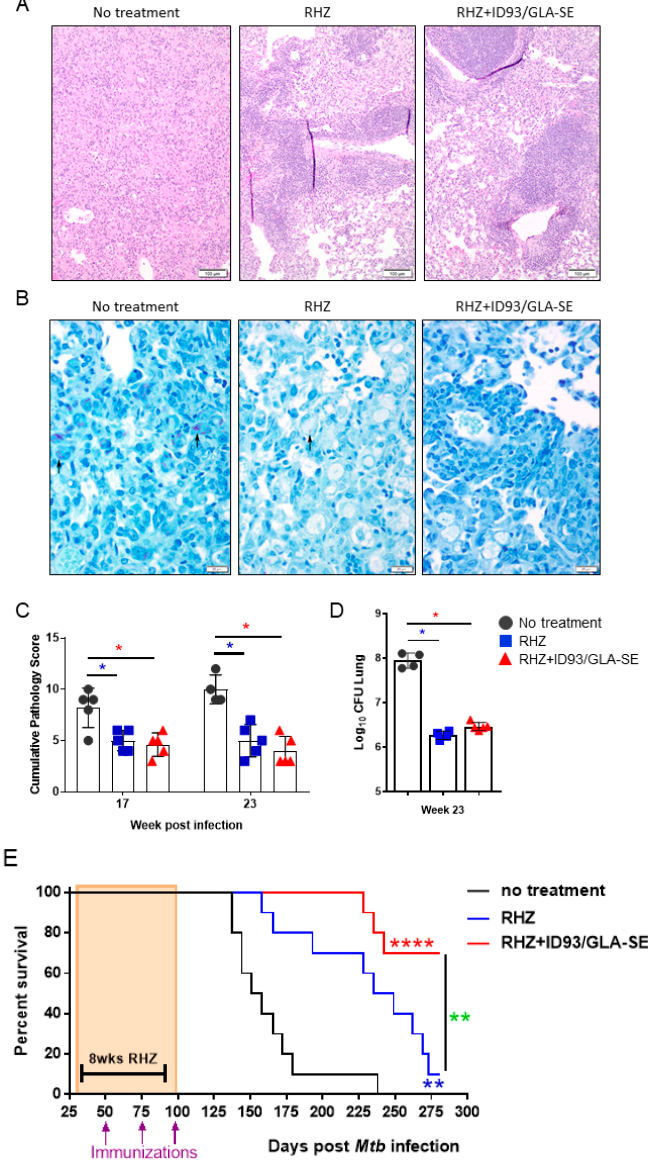
Figure 7. Improved survival with RHZ drug treatment plus immunotherapy. ( A ) Representative H and E and ( B ) AFB histological images from mice that received no treatment, or RHZ or RHZ+ID93/GLA-SE treatment 23 weeks post Mtb challenge. AFB denoted by arrows. ( C ) The cumulative score of lung pathology over time. Histological analyses are representative of two independent experiments. All data were evaluated using two-way ANOVA and Sidak’s correction for multiple comparison. The asterisk denotes significance where p < 0.05. ( D ) Bacterial burden in the lungs 23 weeks post infection from untreated (dark grey, circles), RHZ (blue, squares) or RHZ+ID93/GLA-SE (red, triangles) treated mice. Comparisons between groups performed using one-way ANOVA with Sidak’s multiple comparison test. p < 0.05 denoted by an asterisk. ( E ) The percent survival over time of cohorts of 10 mice/group that received no treatment (dark grey), RHZ (blue), or RHZ+ID93/GLA-SE (red) treatment. Groups were compared using Log-rank (Mantel Cox) test, and asterisks represent a significant difference between groups: blue = no treatment v RHZ, red = no treatment v RHZ+ID93/GLA-SE and green = RHZ v RHZ+ID93/GLA-SE. ** p < 0.01 and **** p <